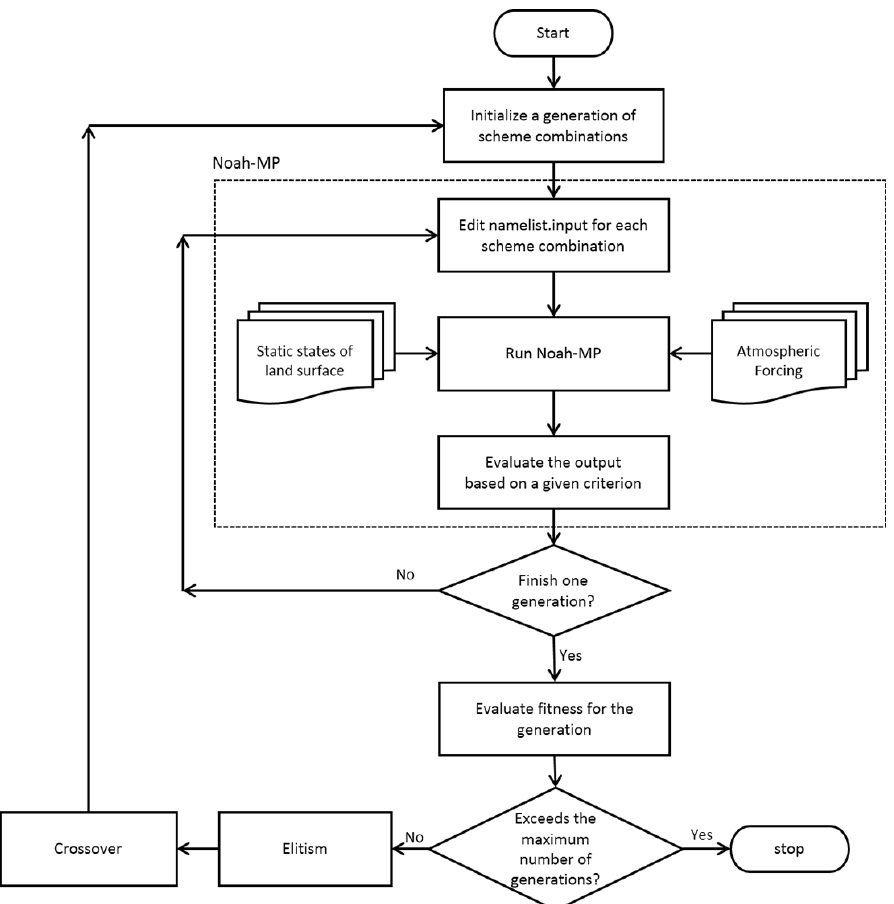
Figure 1. A flow chart describing the scheme-based optimization process from the coupled micro-GA and Noah-MP